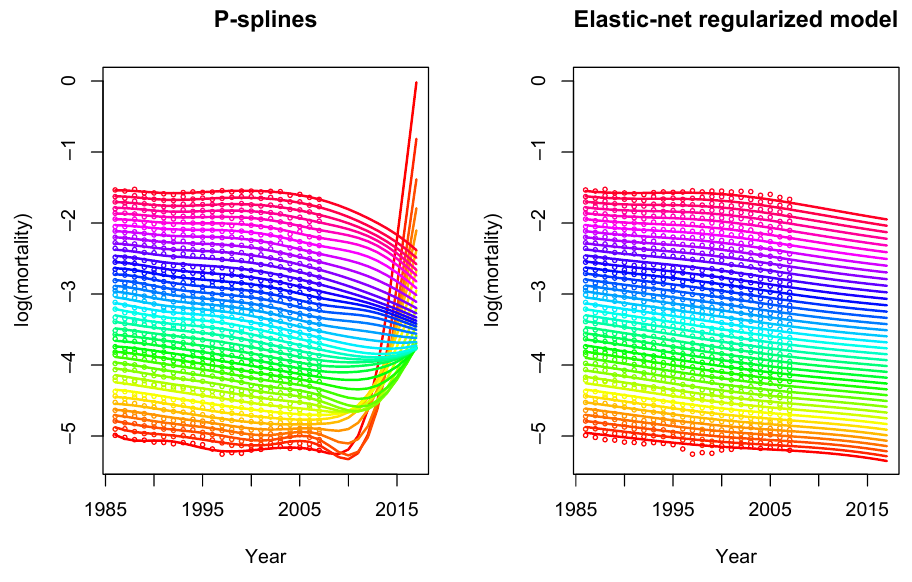
Figure 4. Logarithm of the fitted death rates and forecast death rates for USA by ages (50–90) over years (1986–2017). On the left : forecast by the P-spline model. On the right : forecast by our regularized elastic-net